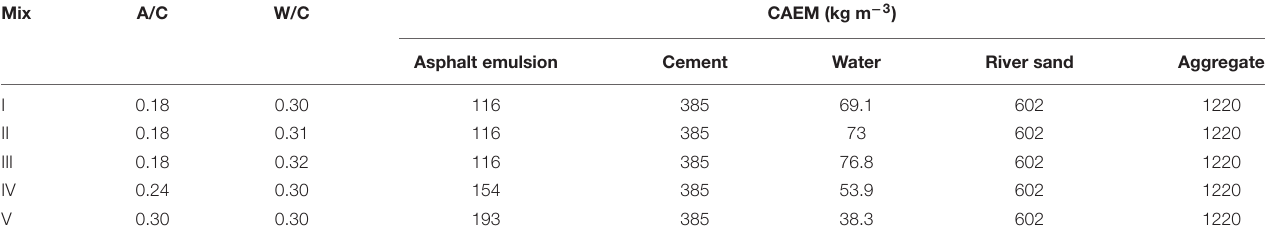
TABLE 3 | Mix proportions of CAEM.